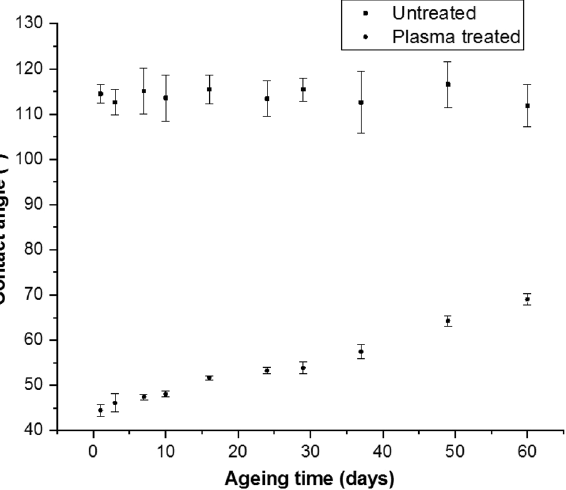
Figure 1. The WCA of untreated and water plasma-treated Bambara groundnuts for the ageing time of 60 days. The samples were treated for 10 s at a discharge power of 10 W. Experiment was performed in triplicates and error bars represent the standard deviation values